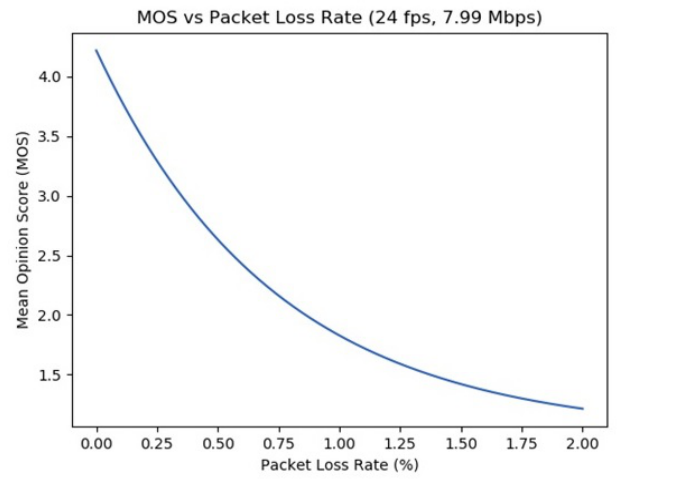
Figure 4. MOS with respect to packet loss (ITU-T Recommendation P.1070).